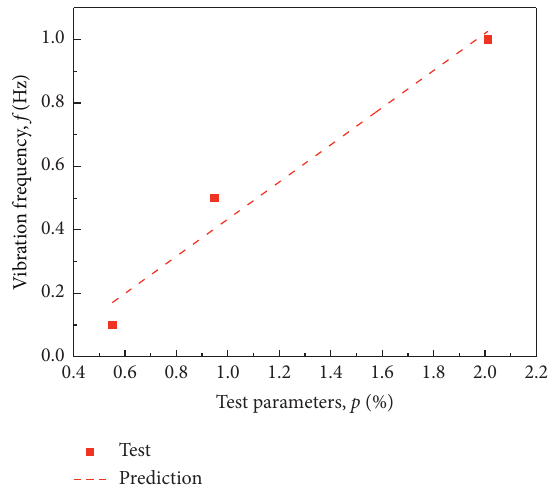
Figure 17: Relationship between parameter p and loading frequency f .